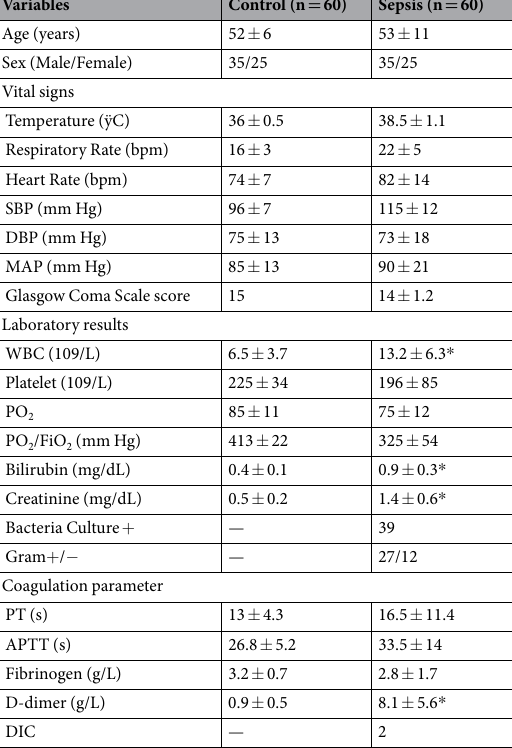
— Table 1. Septic patients’ characteristics. Values given in mean and SD. * P < 0.05 vs. control. Abbreviations: SBP, systolic blood pressure; DBP, diastolic blood pressure; MAP, mean arterial pressure; WBC, white blood cell; PT, prothrombin time; APTT, activated partial thromboplastin time; DIC, disseminated intravascular coagulation.